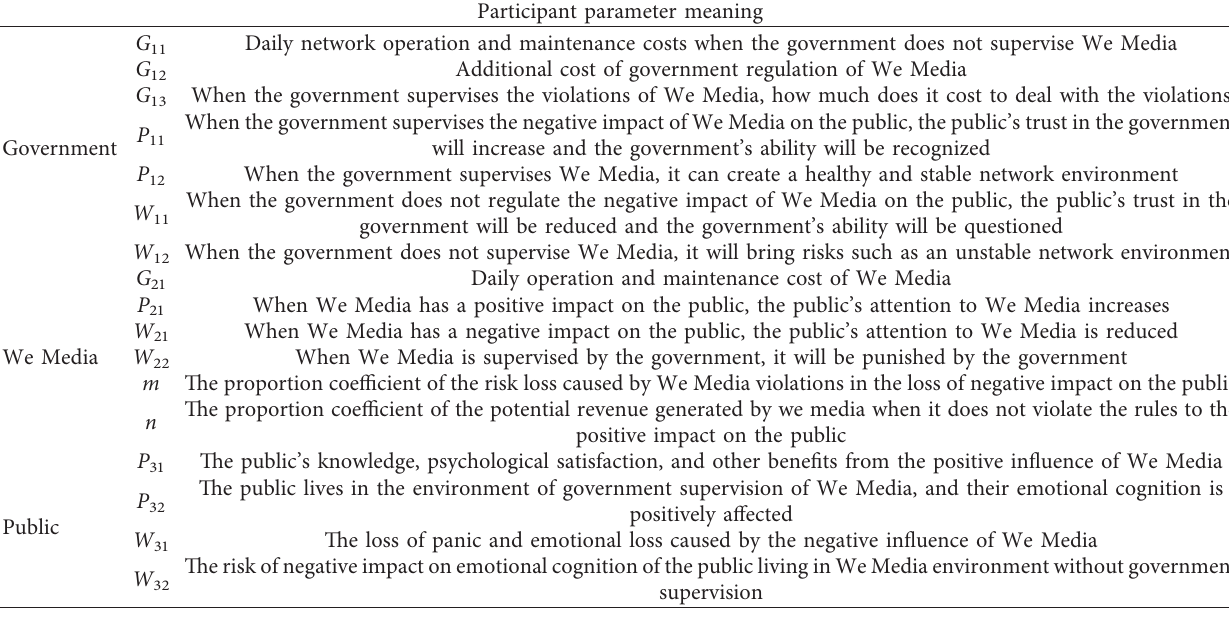
Table 1: Related parameter settings and their meanings of three-party participants.